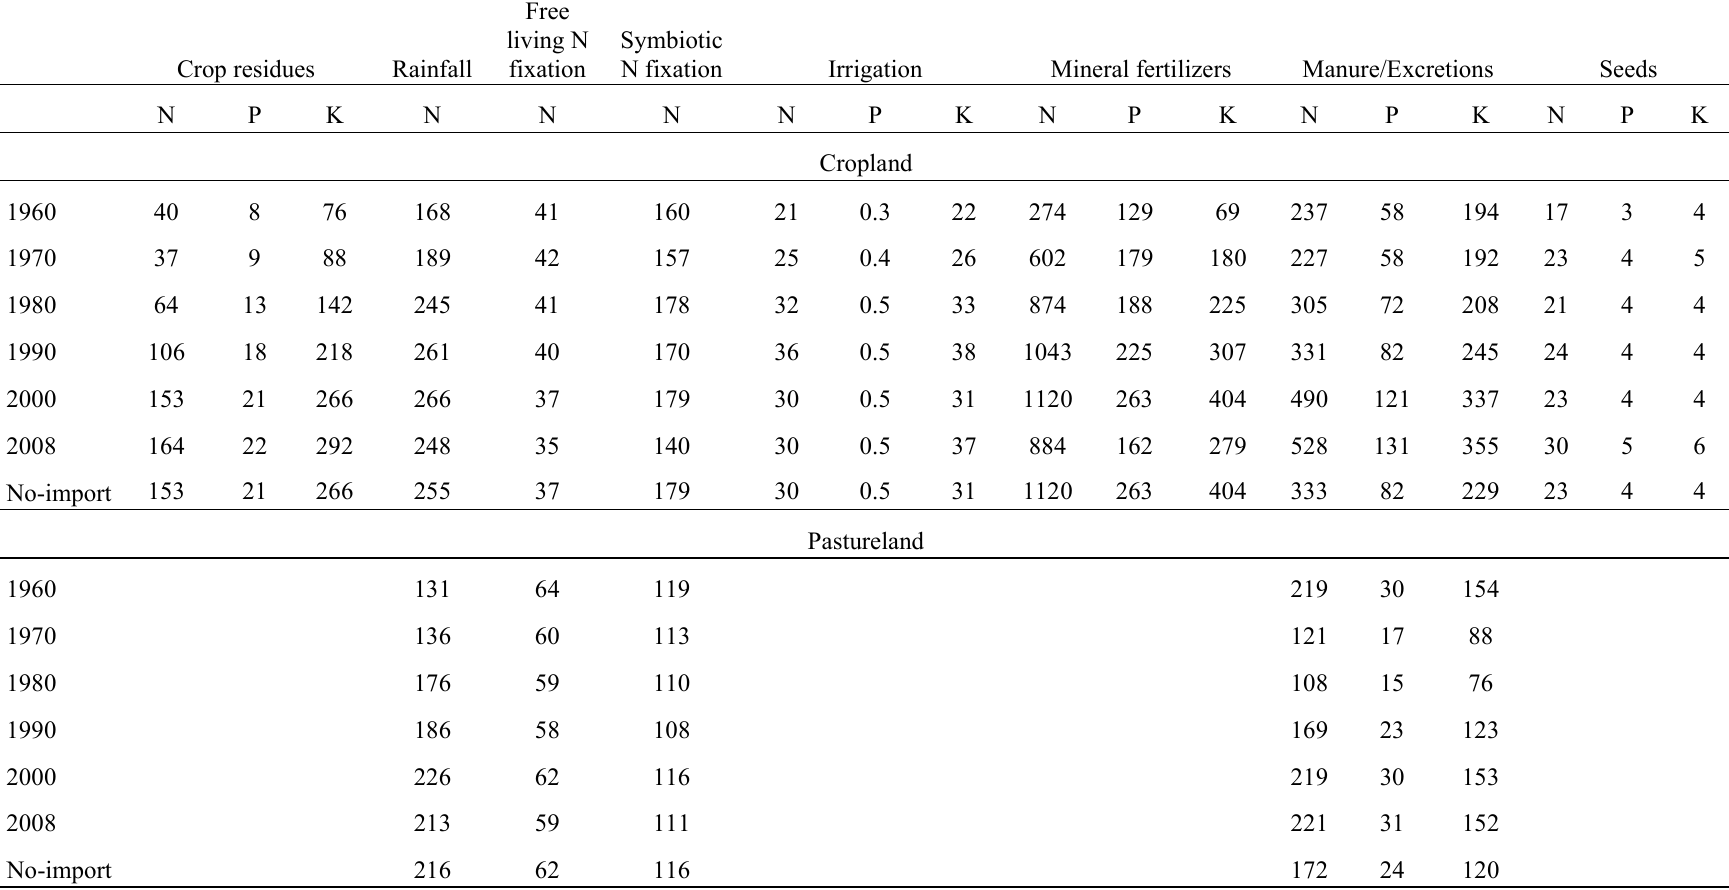
Table A1.4. Inputs of N, P and K in Spanish cropland and pastureland (Gg) Free living N Symbiotic Crop residues Rainfall fixation N fixation Irrigation Mineral fertilizers Manure/Excretions Seeds